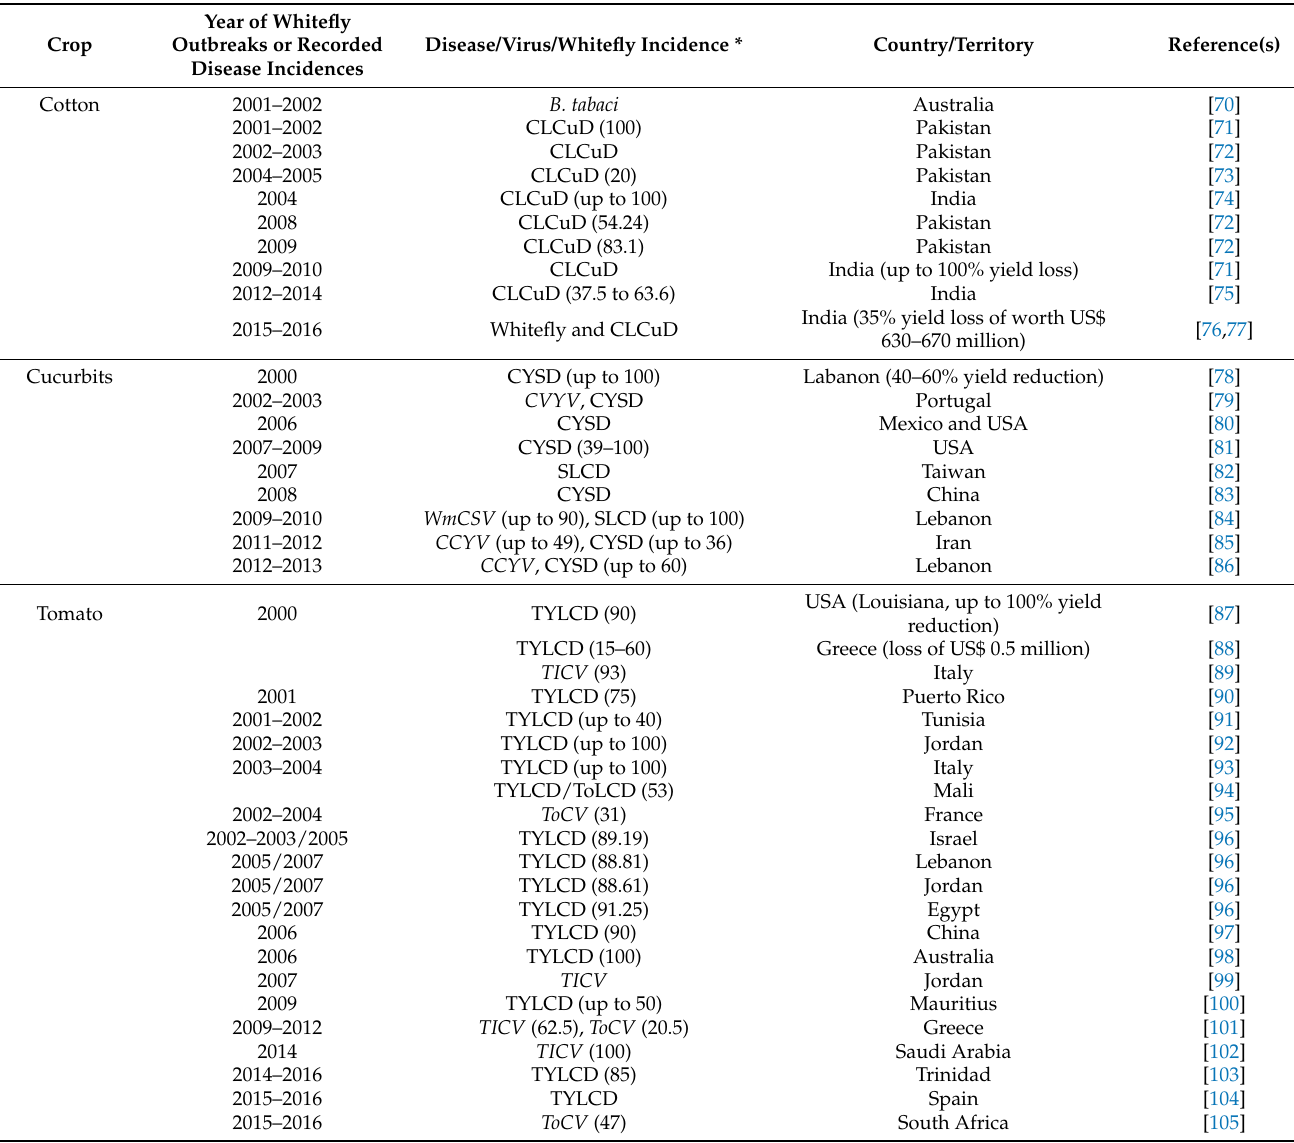
Table 3. Periodic global incidences of whiteflies infestation as well as serious outbreaks of plant diseases vectored by whiteflies on important crops in the last 20